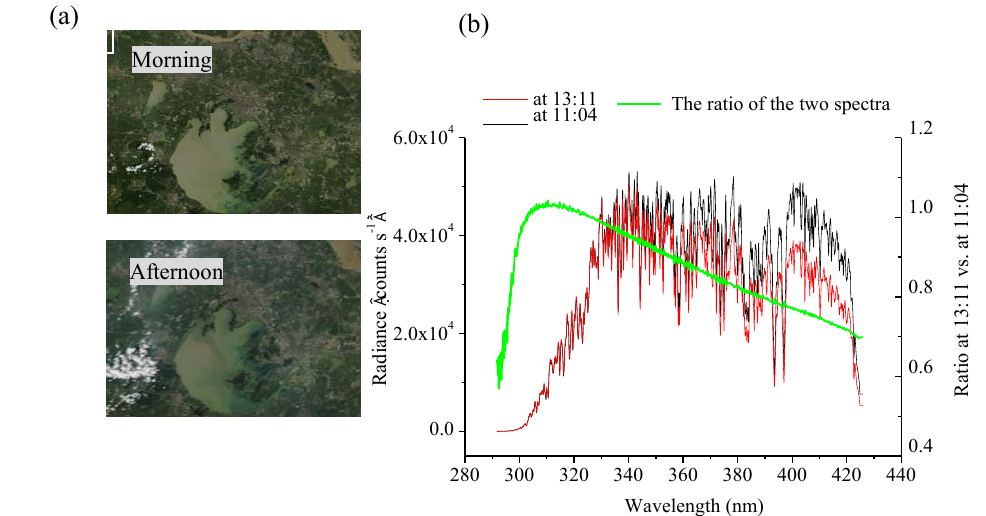
Figure 9. Panel (a) shows visual images of MODIS on 29 July 2012 with the sky condition of extremely high midday CI; (b) zenith spectra in the morning (black) and afternoon (red) measured at a SZA of 20 ◦ . The green curve indicates the ratio of the spectrum in the morning compared to in the